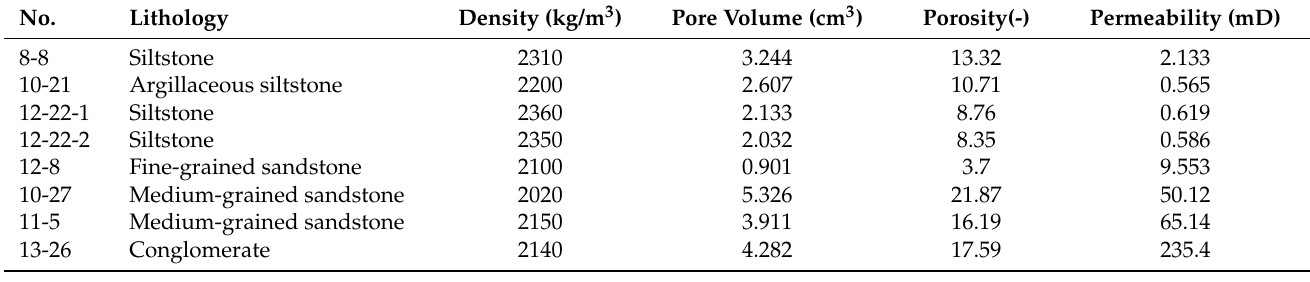
Table 3. Density, porosity, and permeability of typical sandstone samples obtained from the Shuang 6 gas storage.